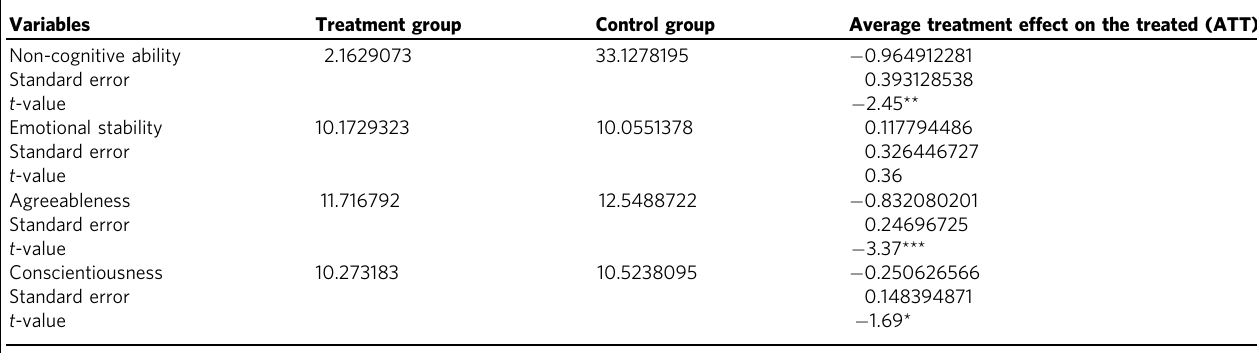
Table 7 The results from the PSM exercise for paternal migrating